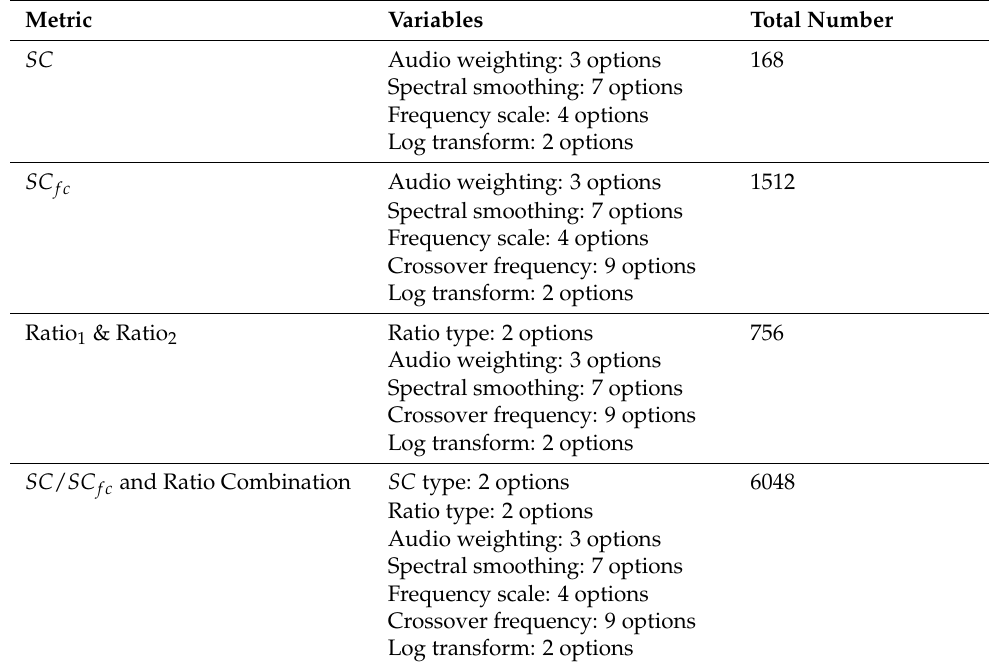
Table 1. Summary of all 8848 candidate metrics for modelling